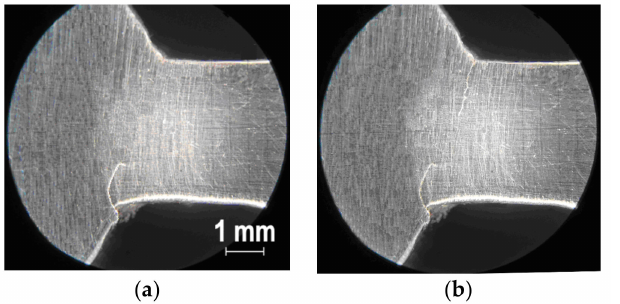
Figure 12. Selected stages of crack development in a specimen with convex welds in bending without HT, where: ( a ) crack initiation; ( b ) crack initiation and propagation.